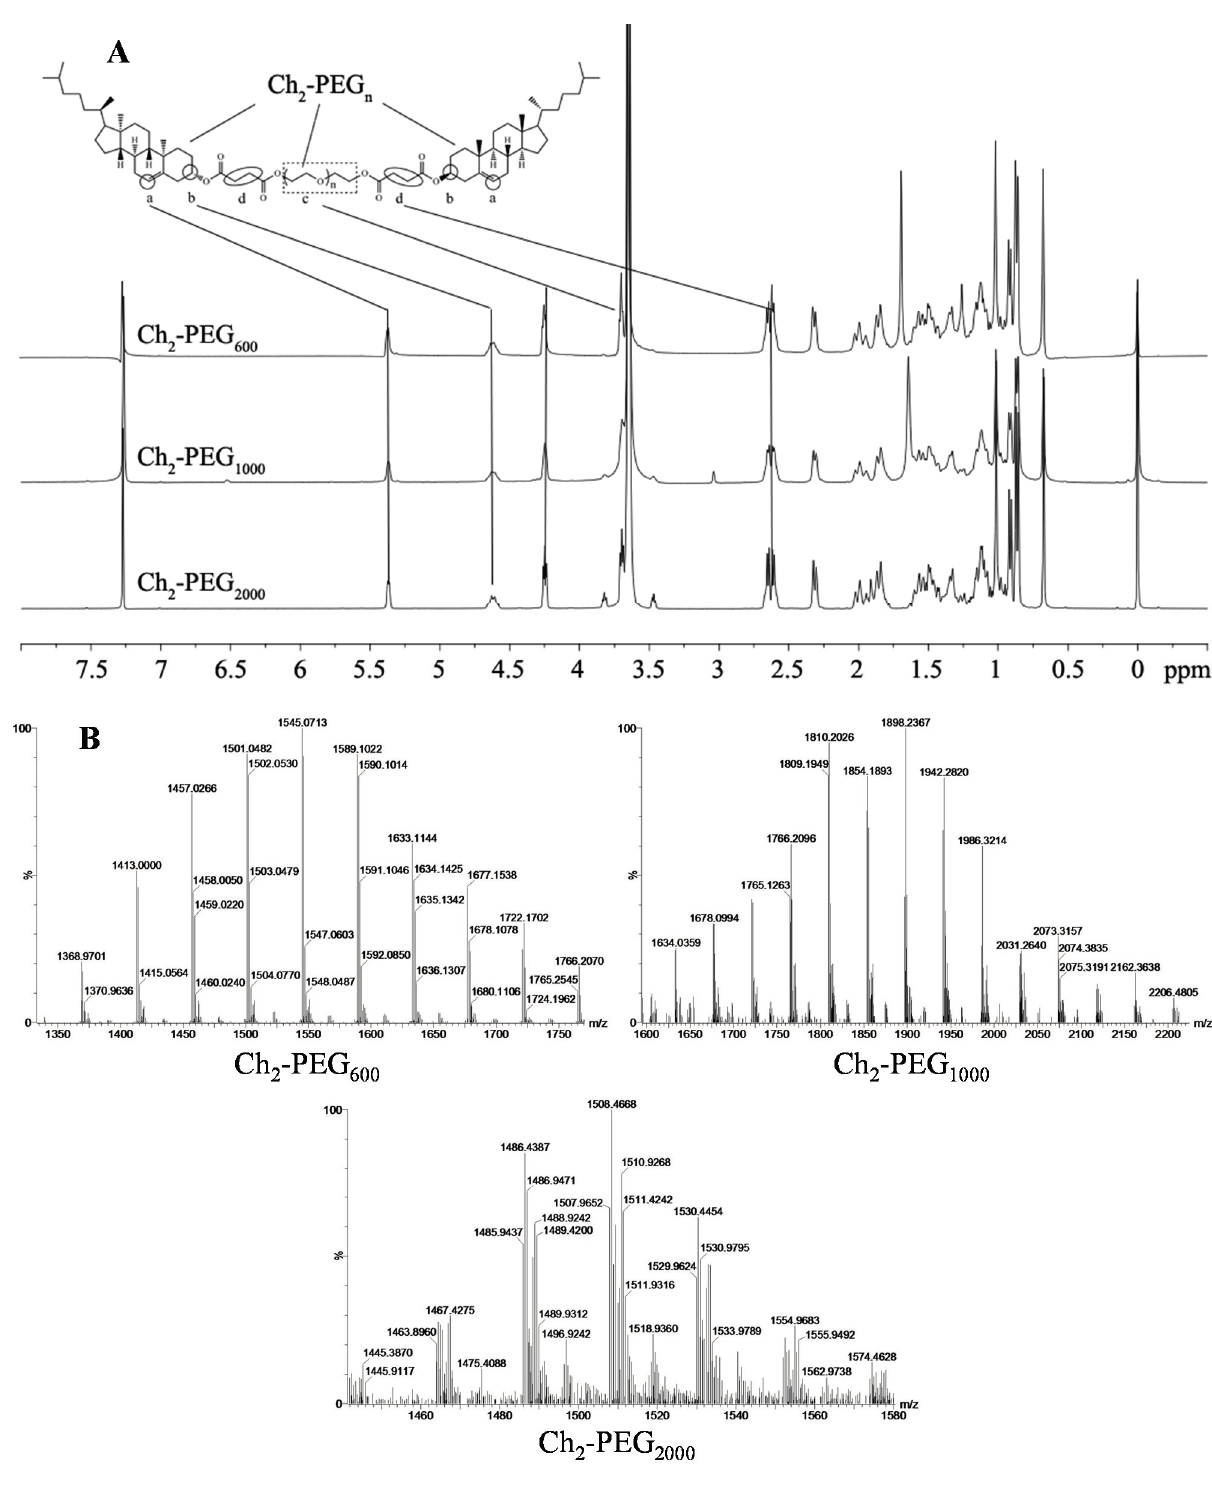
Figure 1. 1 H-NMR and mass spectra of Ch 2 -PEG n . ( A ) 1 H-NMR spectra (400 MHz) of Ch 2 -PEG n in CDCl 3 ; ( a , b ) 6- and 3-position protons in Chol; ( c ) protons of methylene in PEG and ( d ) methylene proton of succinyl group. The principal proton peaks of Chol-suc and PEG were found in Ch 2 -PEG n ; ( B ) Mass spectra of Ch 2 -PEG n . The m / z ions of Ch 2 -PEG 600 and Ch 2 -PEG 1000 are singly charged molecular-related ions; the m / z ions of Ch 2 -PEG 2000 are doubly charged molecular-related ions. The measured molecular weight of Ch 2 -PEG 600 , Ch 2 -PEG 1000 and Ch 2 -PEG 2000 were 1544, 1895 and 3012 Da,